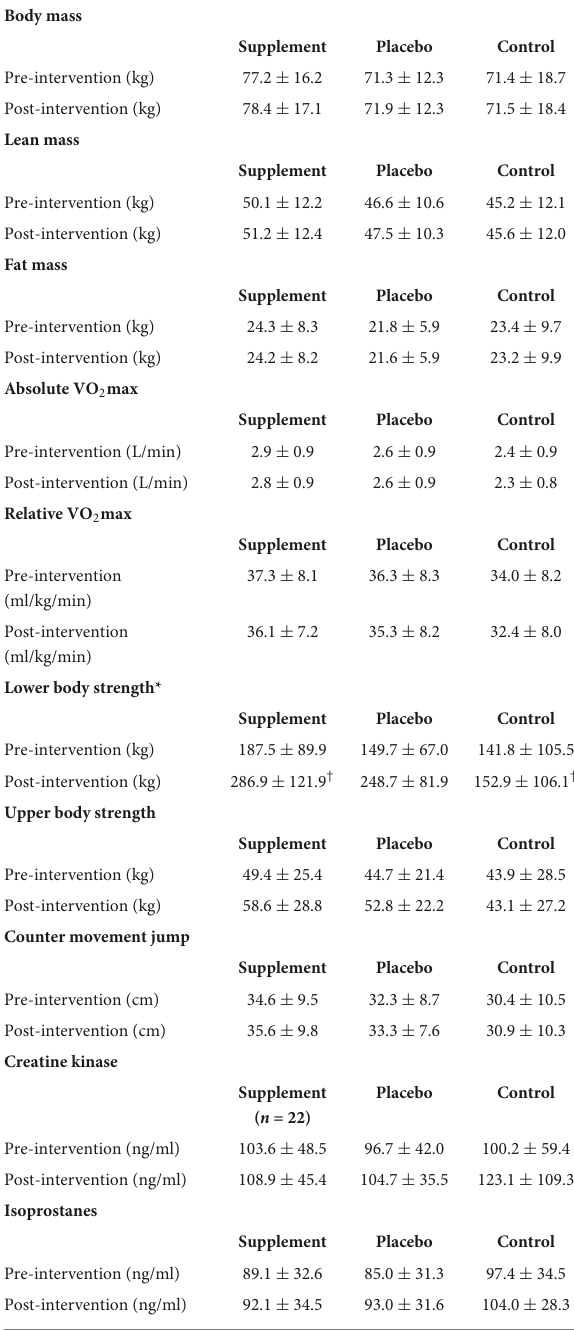
TABLE 3 Body composition, performance, and blood analyte variables presented as mean ± standard